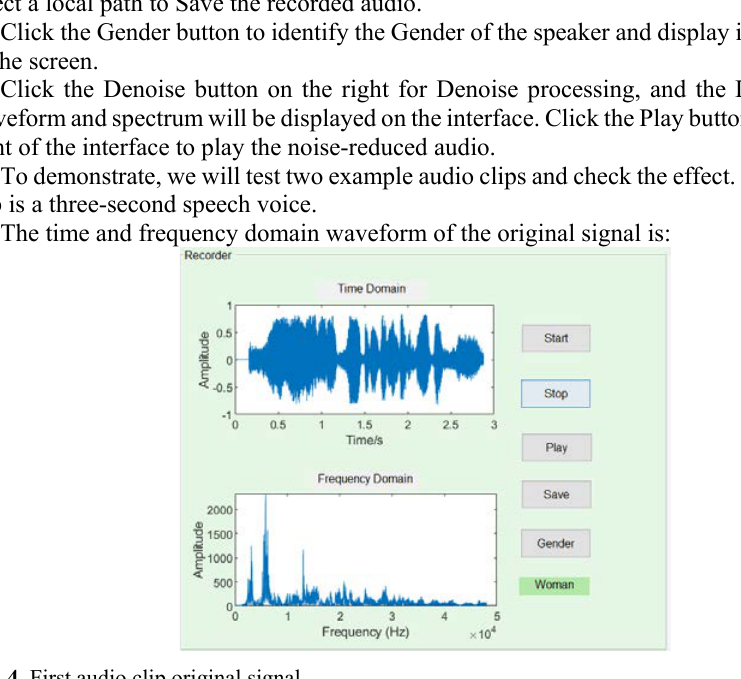
Fig. 4. First audio clip original